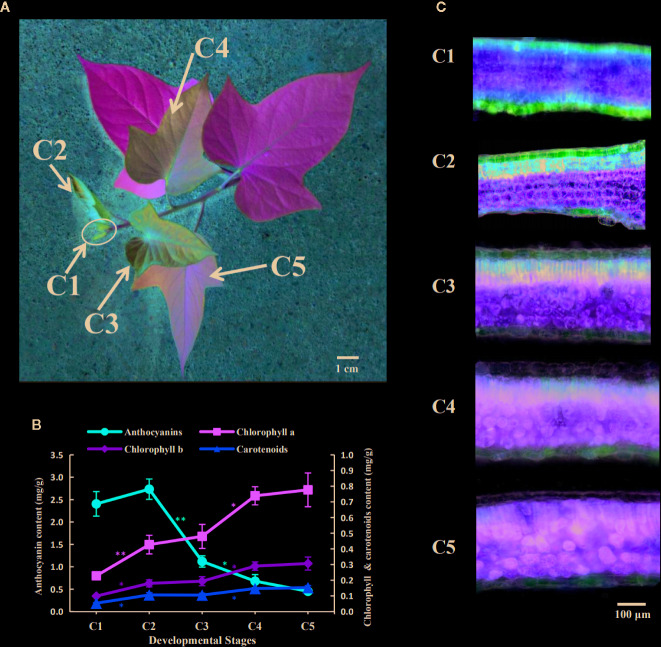
Pigment accumulation during the leaf development of the sweetpotato “Chuanshan Zi”. (A) The leaf development stages from C1 to C5. With the apical tip of each vine defined as the first stage C1, and the leaves beneath and along the vine are defined as stages C2 to C5. The scale bar indicates a length of 1 cm. (B) The pigment content alterations for the five stages, including anthocyanins, chlorophylls, and carotenoids. The bars depict the standard errors (SEs) of three biological replicates. The difference significances were tested for adjacent stages by t-test and asterisks indicate significant differences at p < 0.05 (*) and p < 0.01 (**). The color of the asterisks corresponds to that of the pigments. (C) Microscopic cross sections of leaves showing the anthocyanin distributions. Leaf sections were magnified at 200×. The scale bar indicates a length of 100 µm.